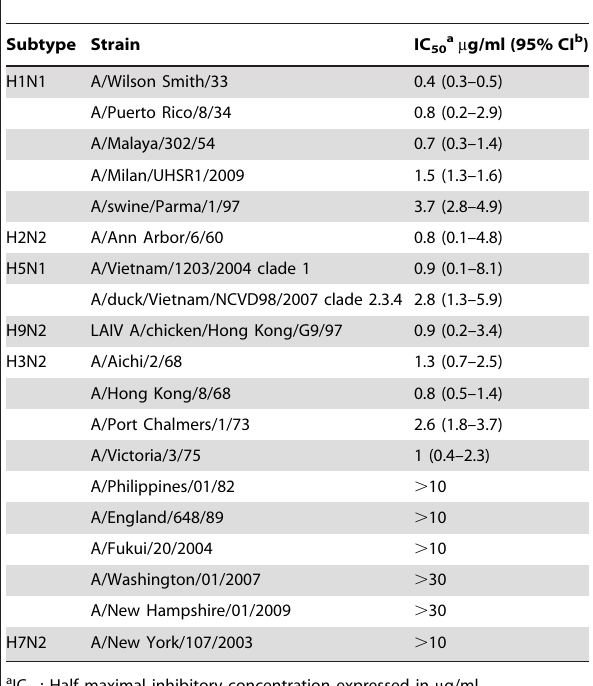
Table 1. PN-SIA28 neutralizing activity against all tested